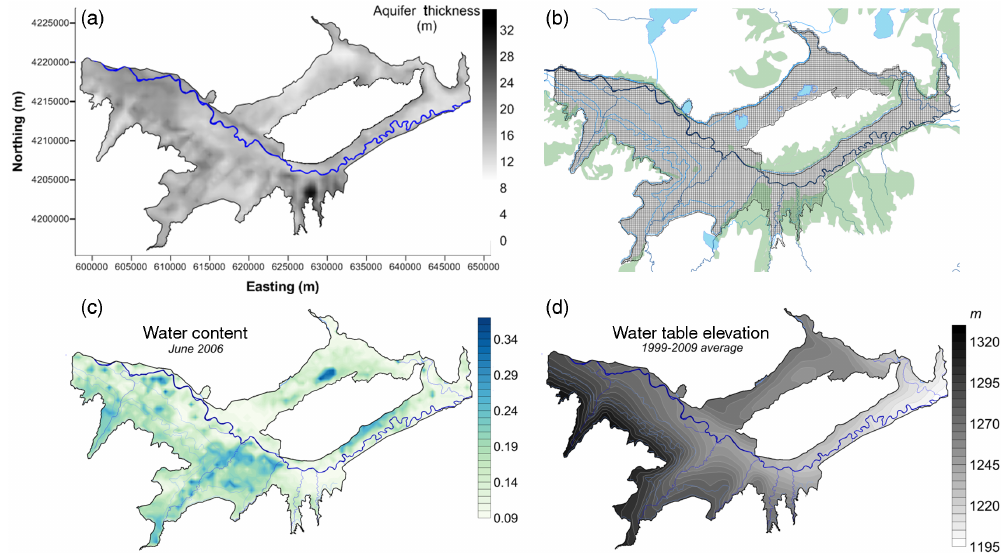
Figure 4. (a) The spatial distribution of aquifer thickness (m) of the alluvium in the study region, (b) the finite-difference grid used in the calibrated and tested MODFLOW-UZF1 groundwater flow model, using 250m by 250m grid cells, (c) spatial distribution of soil water content simulated by the MODFLOW-UZF1 model, for June 2006, and (d) average-simulated water table elevation for the 1999–2009 time